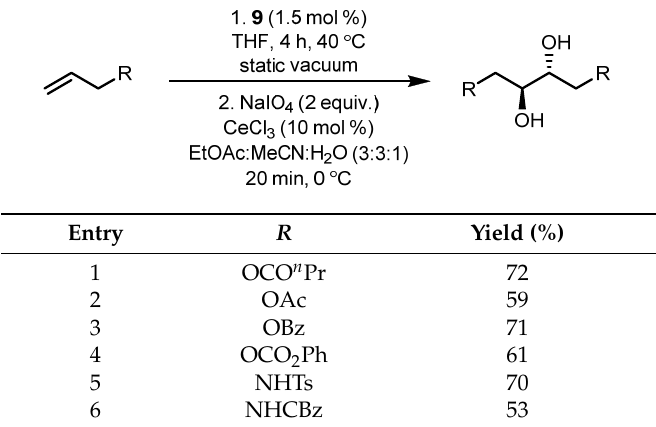
Table 22. Anti -diols synthesized through tandem catalysis.